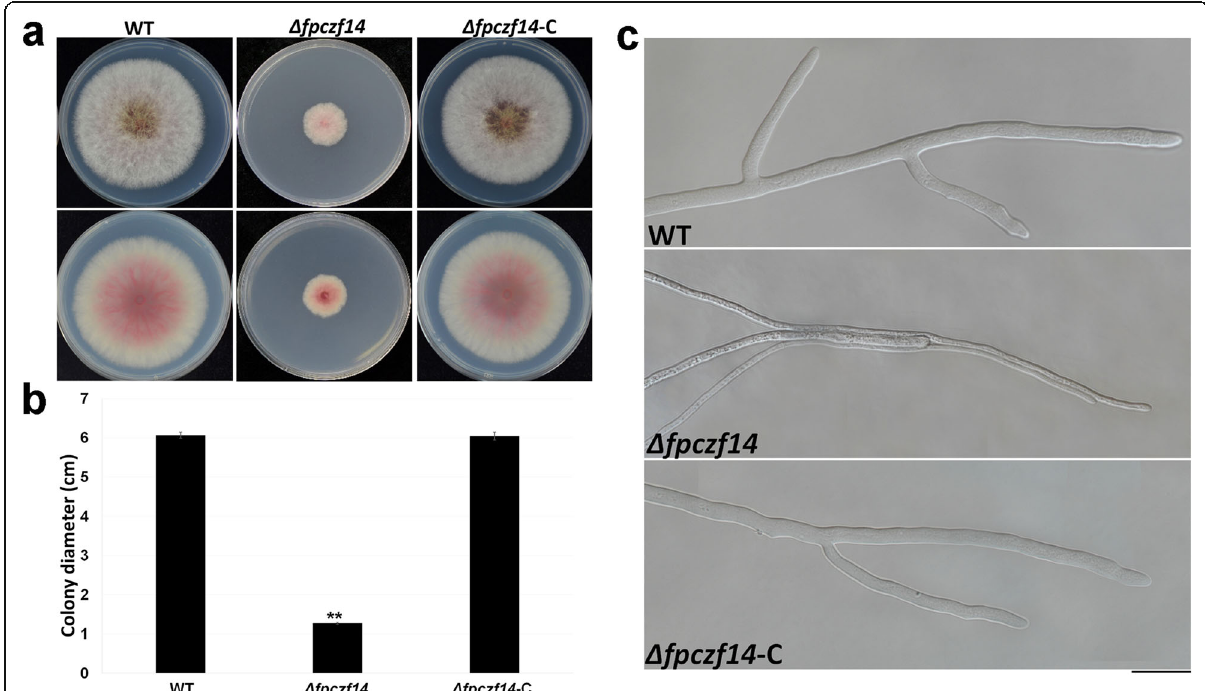
Fig. 3 FpCzf14 deletion affects growth and conidiation of F. pseudograminearum . a Colony morphology of WT, Δ fpczf14 and Δ fpczf14 -C grown on PDA plates at 25°C for 3 d. b Colony diameters of WT, Δ fpczf14 and Δ fpczf14 -C grown under the same conditions as in a. ( t -test, ** P <0.01). c Microscopic observation of hyphal tip growth and branching patterns of WT, Δ fpczf14 and Δ fpczf14 -C grown on a PDA plate for